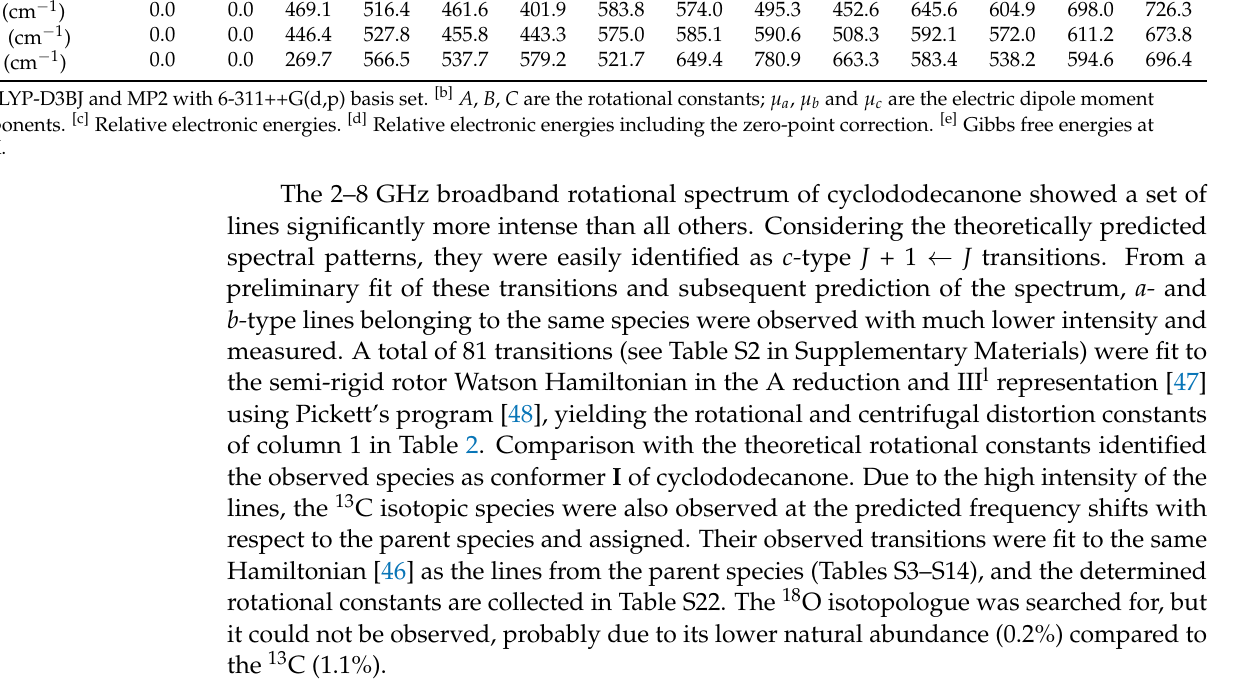
Table 2. Experimental spectroscopic parameters of the seven observed conformers of cyclododecanone.